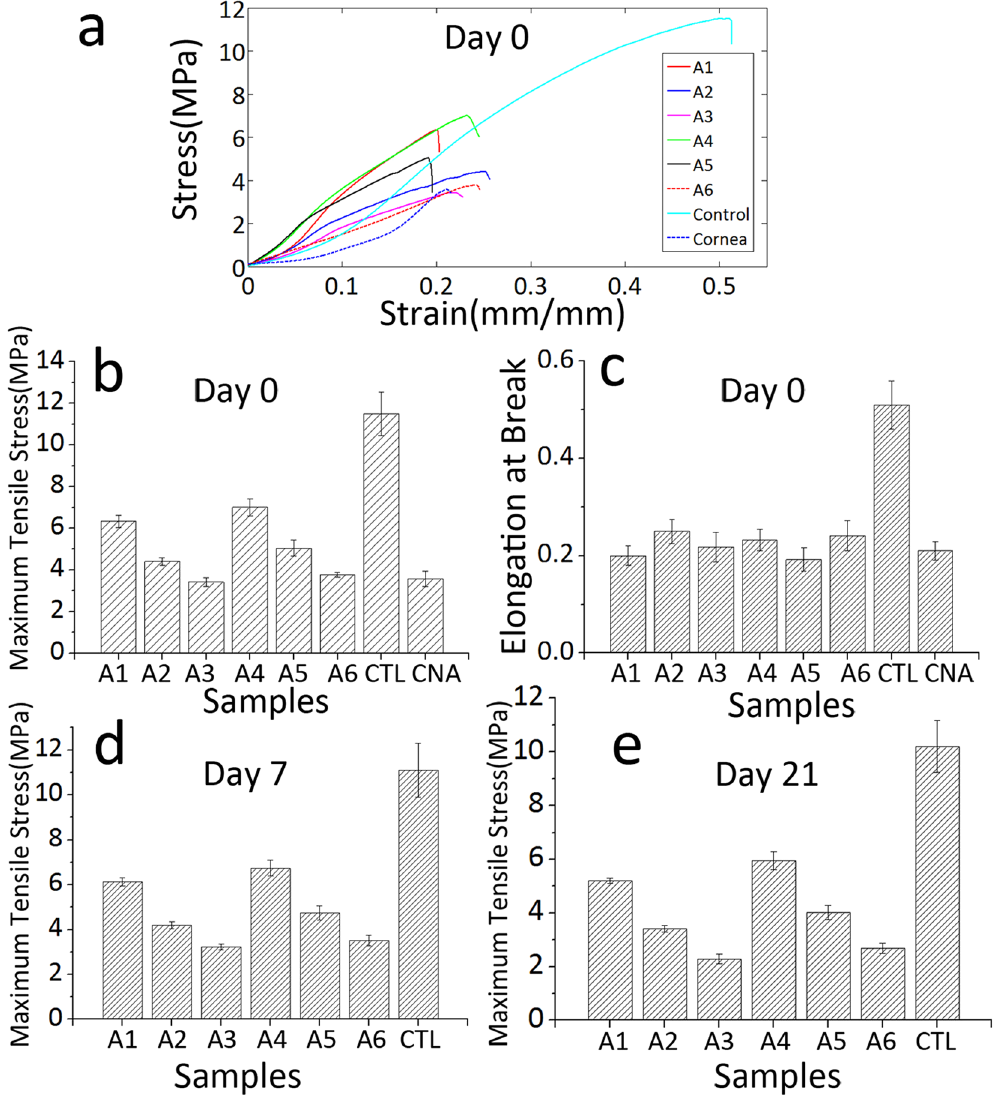
Figure 5. Mechanical properties: ( a ) Average strain-stress curves of hybrid constructs A1-A6, the control group and the acellular pig cornea after incubating in PBS for 1 h; ( b ) maximum tensile stress histogram of the samples in ( a ), CTL is the control group and CAN is the acellular pig cornea; ( c ) histogram of strain at break of the samples in ( a ); histogram of maximum tensile stress of hybrid constructs A1-A6 and the control group after incubating in PBS for 7 days ( d ) and 21 days ( e